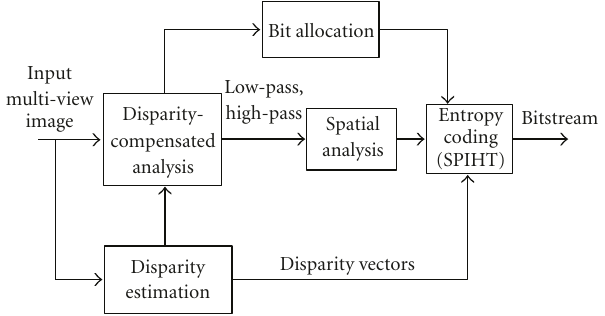
Figure 1: The overview framework of the proposed multiview image